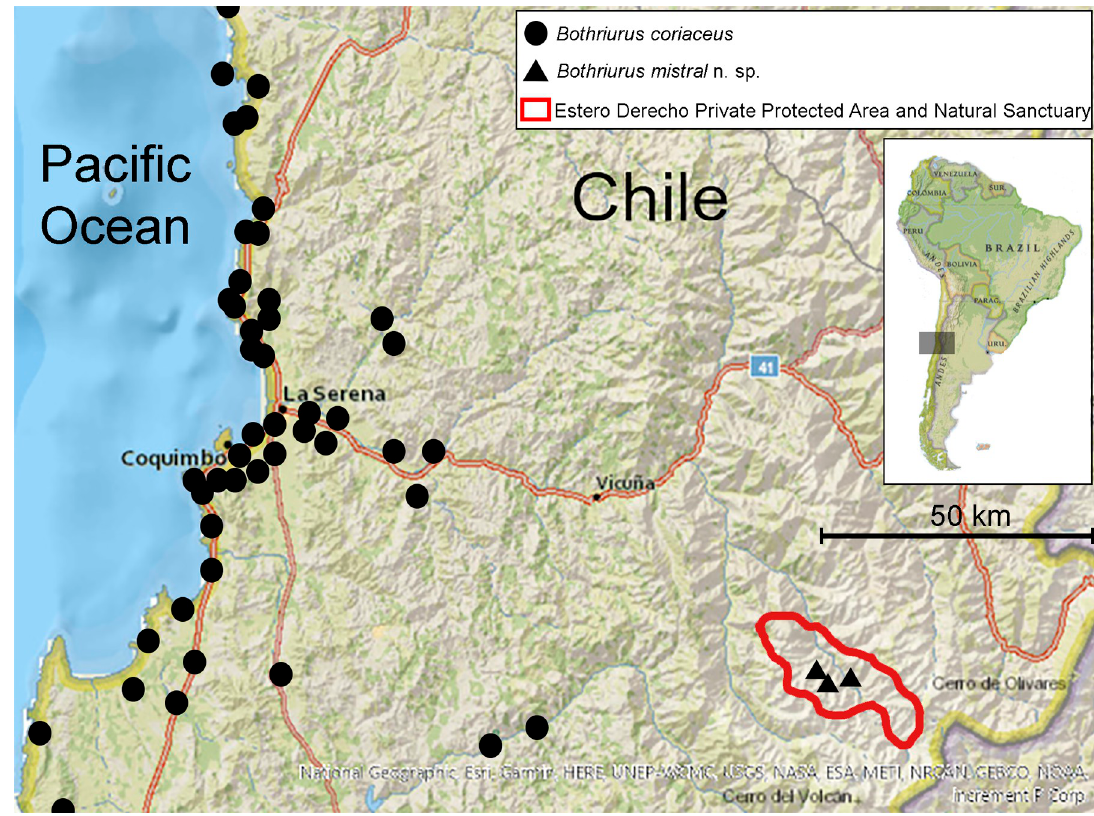
Fig 1. Distribution map of Bothriurus mistral n. sp. (black triangles) and distribution of Bothriurus coriaceus in neighboring areas (black circles). Estero Derecho Private Protected Area and Natural Sanctuary marked with a red line, (Coquimbo Region, Chile).